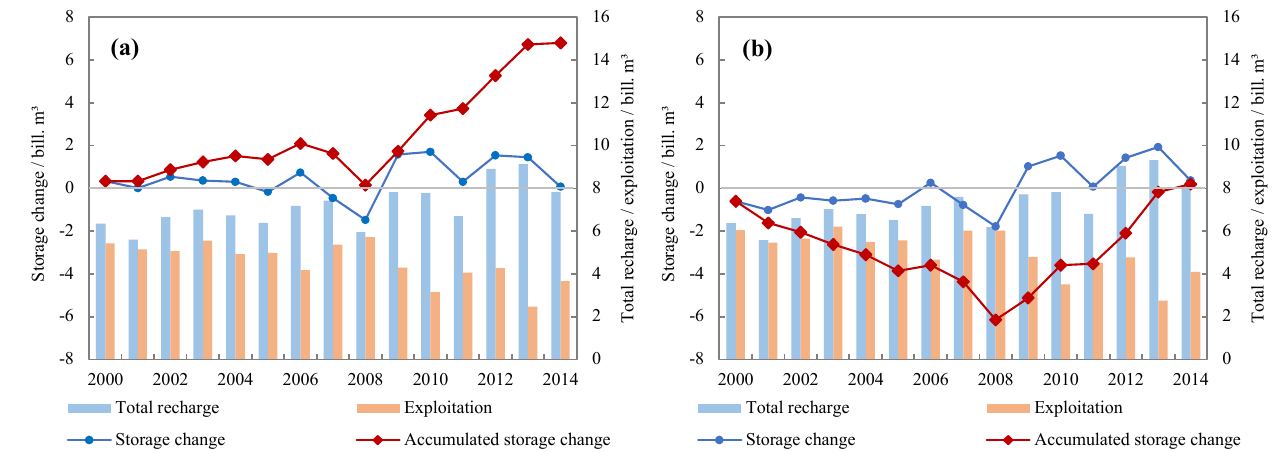
Figure 7. Main groundwater fluxes and storage change under planned rice area ( a ) and suitable rice area ( b ). All data of the two models are the same, except for the rice area; ( b ) is 0.054 million hm 2 more than ( a ). The meteorological data are from 2000 to 2014, so the abscissa still uses this simulation period.